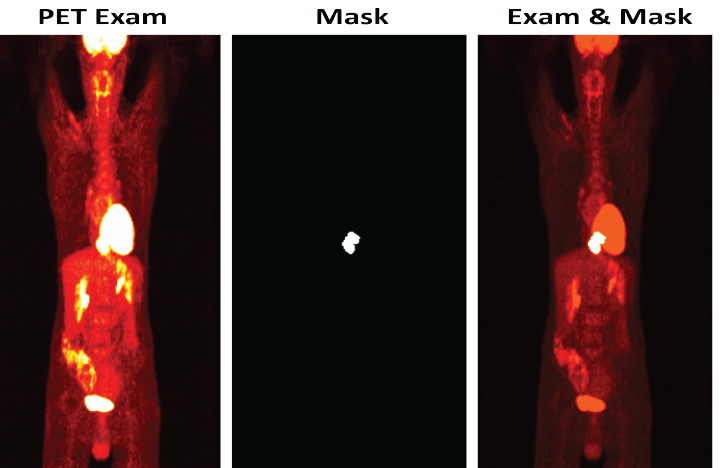
Figure 1. An example of a positron emission tomography (PET) image with esophageal cancer on the left in which the tumor is barely visible, and the same image on the right in which the location of the tumor is shown in a brighter color. It is not straightforward to learn the difference between tumor fixation and a normal fixation in a PET